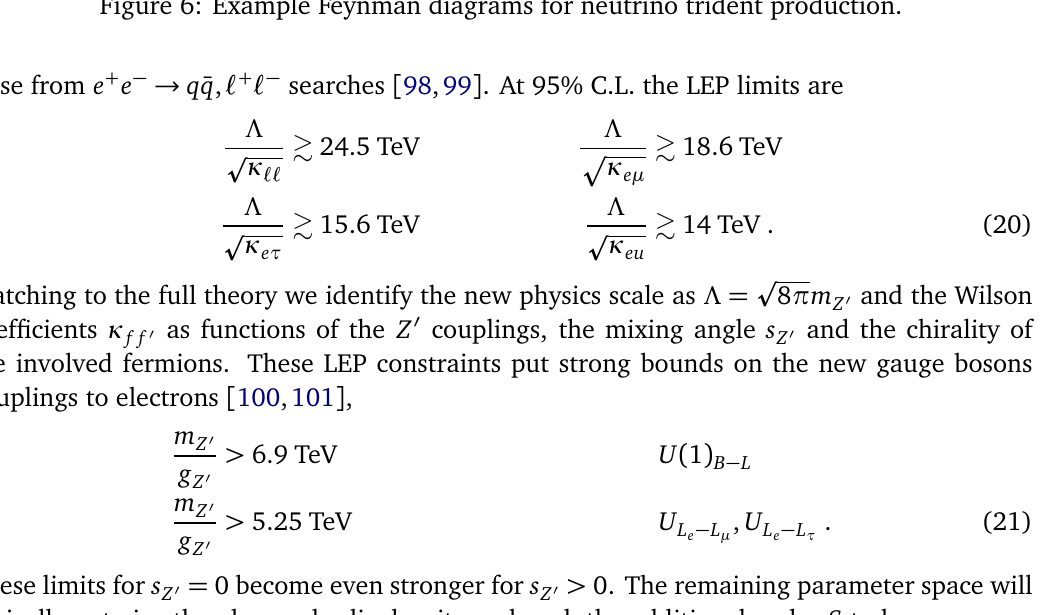
Figure 6: Example Feynman diagrams for neutrino trident